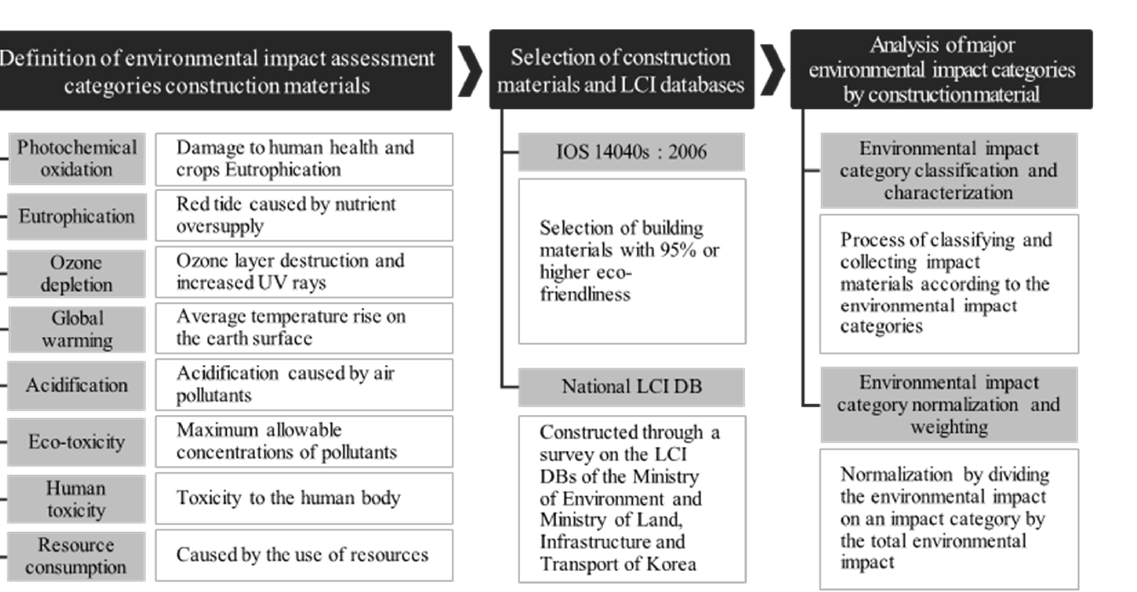
Figure 1. Research flow and framework.